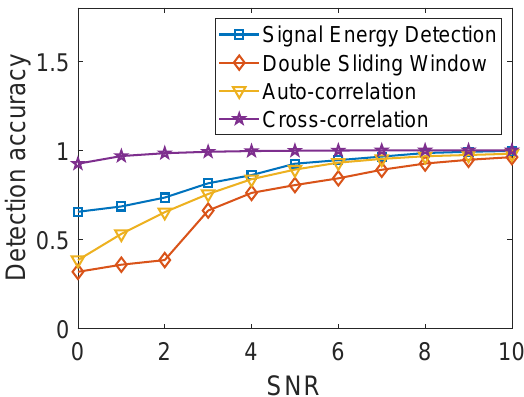
Figure 19. Detection rate for four algorithms.